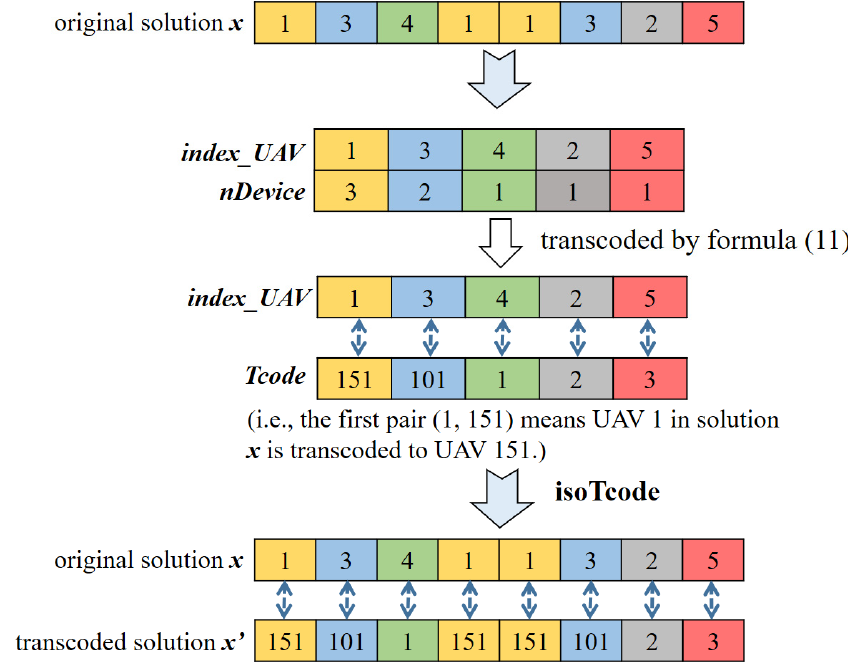
Figure 5. An example of the isoTcode operator.